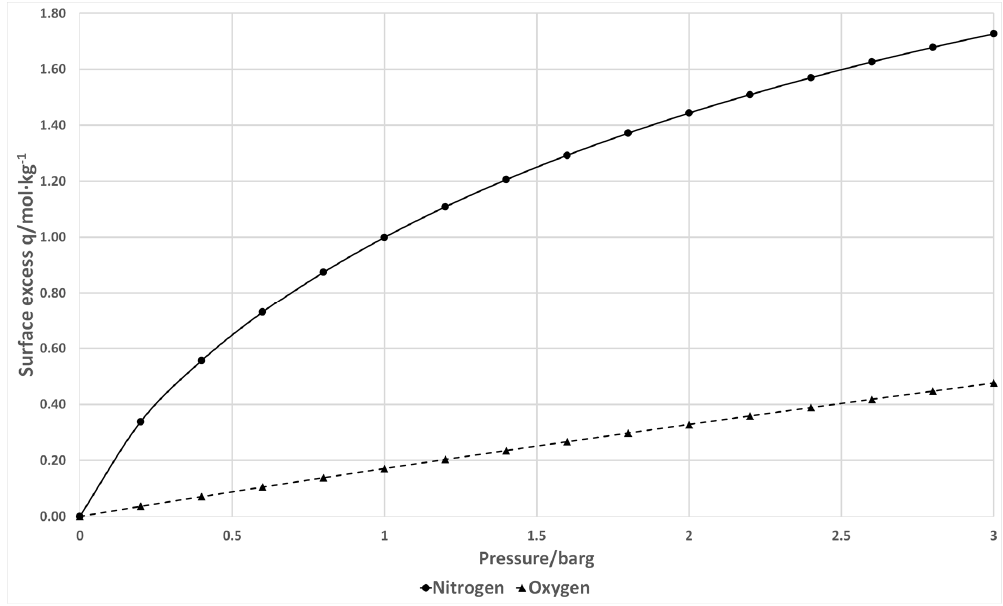
Figure 3. Adsorption equilibrium isotherms for nitrogen and oxygen onto zeolite LiX at 20 °C. Reproduced with permission from [17]. Industrial & engineering chemistry research, 2008.